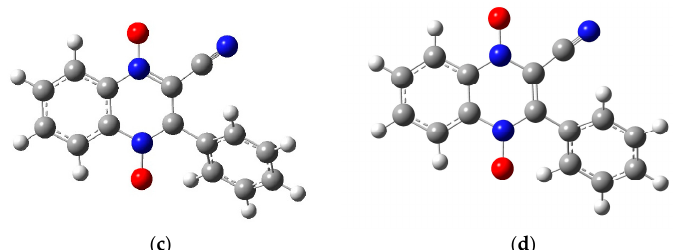
Figure 7. The optimized structures for molecule 1a using the 6-31g basis set: ( a ) the neutral molecule, ( b ) the anion product from wave 1 with the radical on the carbon attached to the cyano group, ( c ) the anion product of wave 1 with the radical on the carbon attached to the benzene ring, and ( d ) the dianion product of wave 2. Figures created in GaussView 5 [39] and optimized in Gaussian 09 [38].